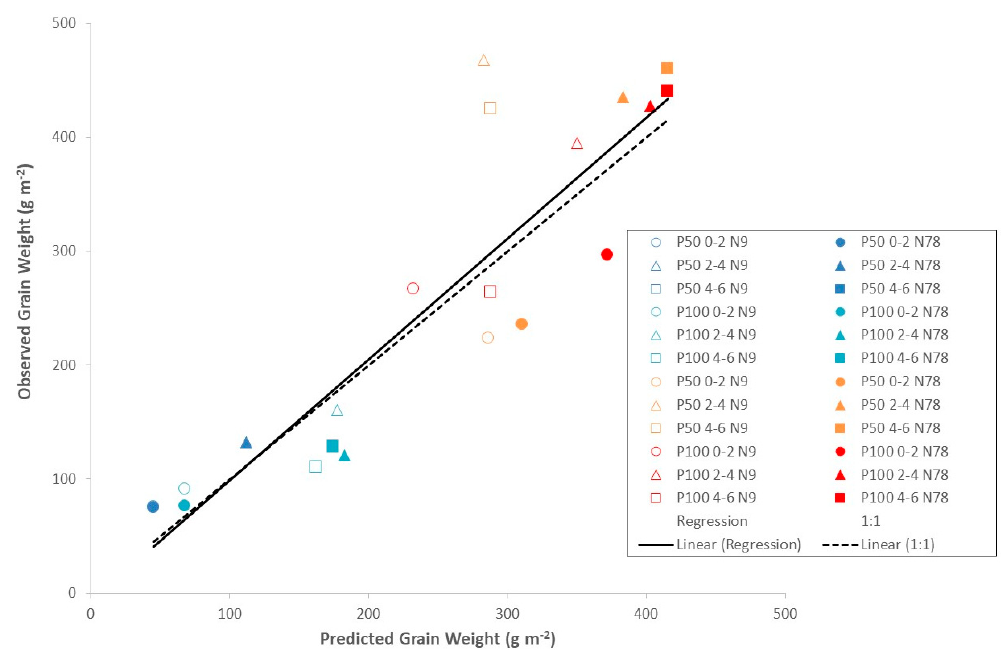
Figure 1. Uncalibrated comparison of observed and predicted maize grain yield grown in all zones under trees in the 2015 (blue symbols) and 2016 (orange and red symbols) cropping seasons. Lines are linear regression (solid) and 1:1 (broken).